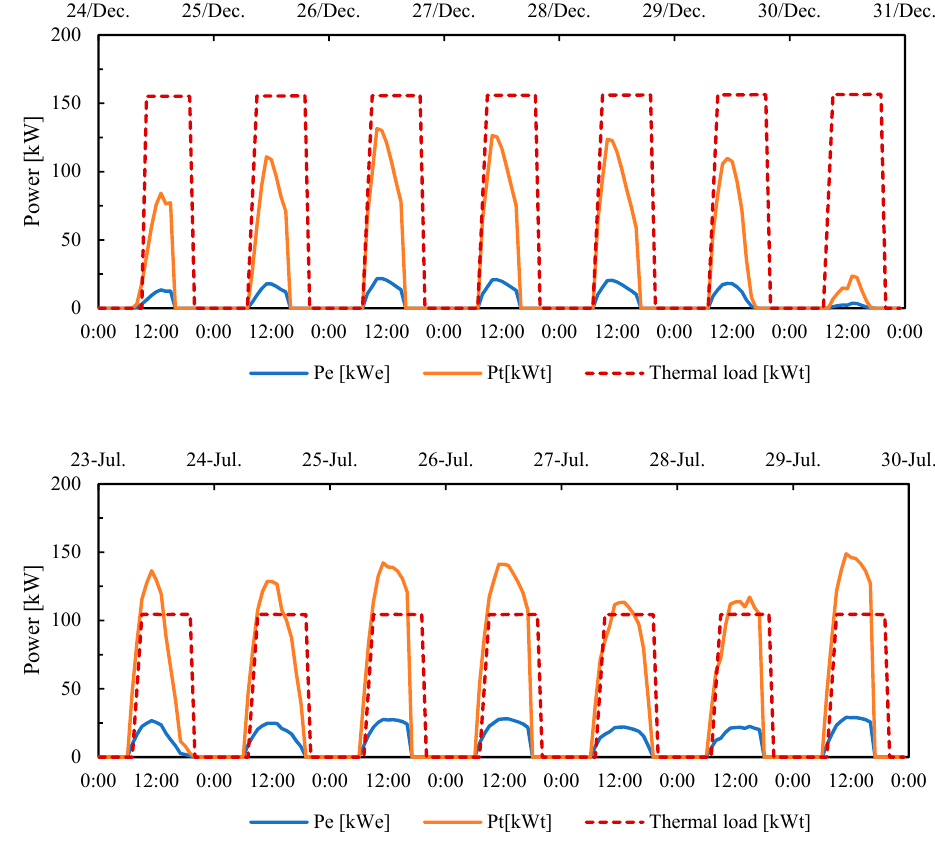
Figure 5. Thermal (Pt) and electrical (Pe) peak powers during the typical weeks of winters ( top ) and summers ( bottom ) (Source: Author own calculation).